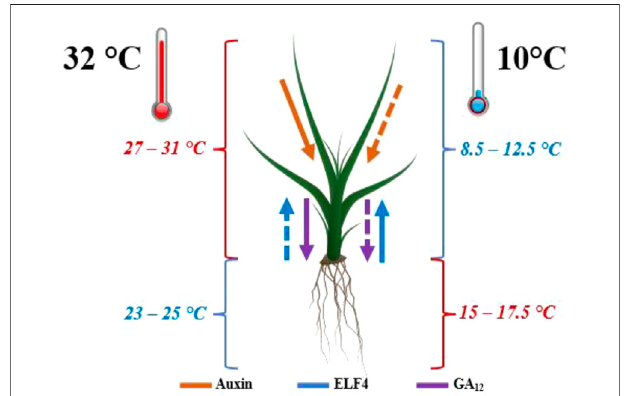
FIGURE 5 | Temperature distribution of bromeliads exposed to varying temperatures: (left) exposed to 25 – 32 ° C for 7 days, and (right) exposed to 10 ° C for 10 days. Solid and dashed lines indicate higher and reduced transmission of signaling molecules: auxin, early fl owering complex (ELF4), and the precursor gibberellin 12 (GA 12 ) respectively, which mediate growth response to ambient temperature changes (Nievola et al., 2017) .